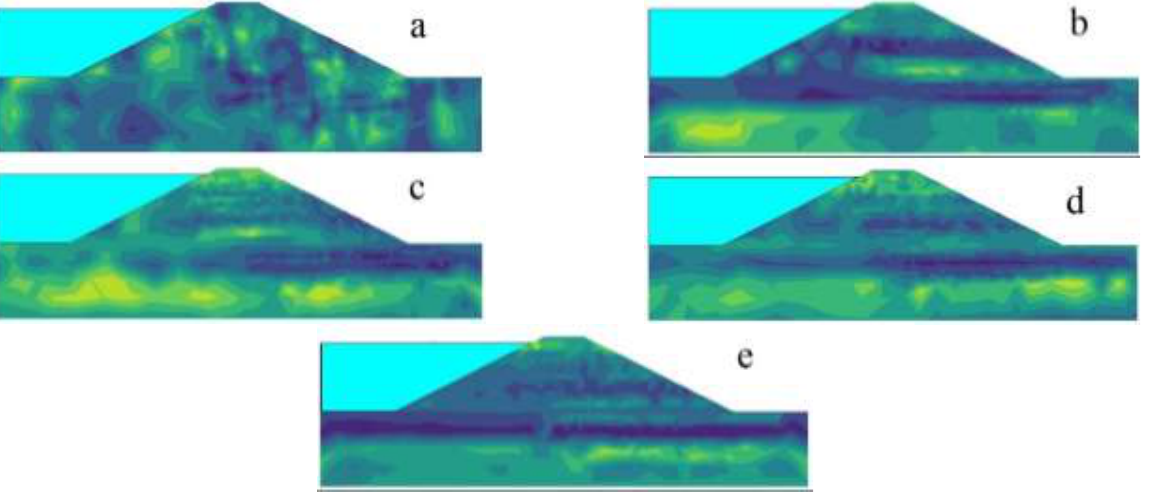
Figure 14. Typical realizations of the random field of cohesion ( µ c = 15kPa, σ c = 5kPa) for different l x (( a ) l x = 1 m, ( b ) l x = 30 m, ( c ) l x = 40 m, ( d ) l x = 50 m, ( e ) l x = 500 m).